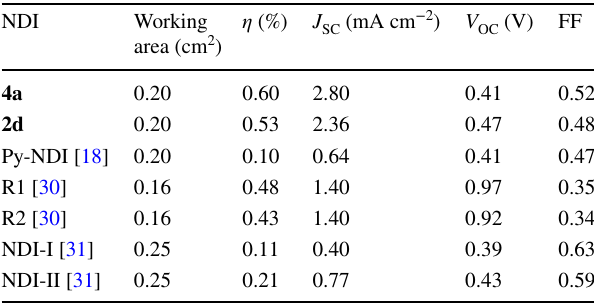
Table 4 Photovoltaic parameter obtained in the DSSC with the NDIs